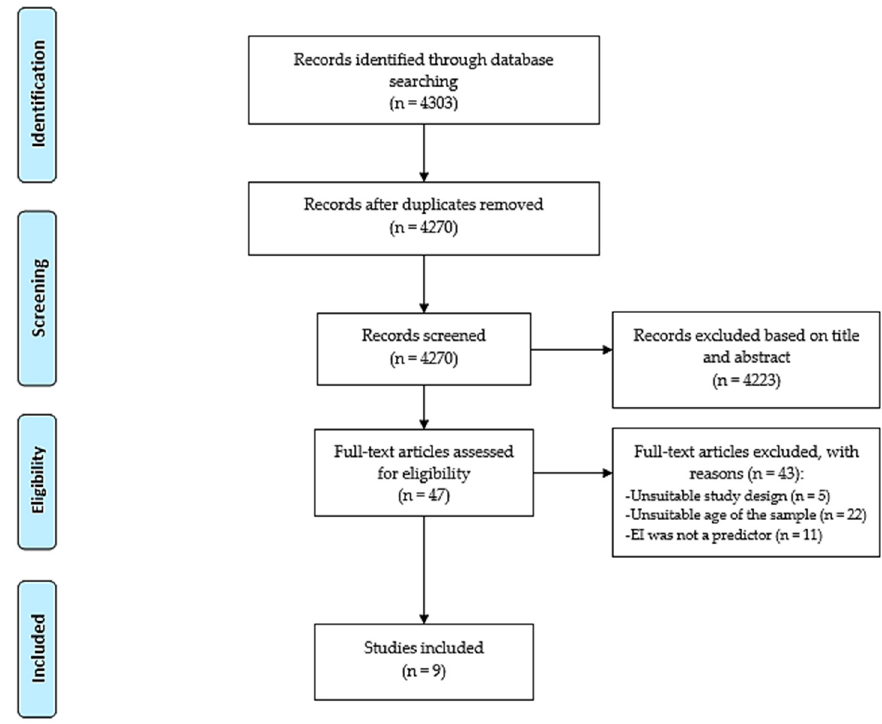
Figure 1. PRISMA flow chart.